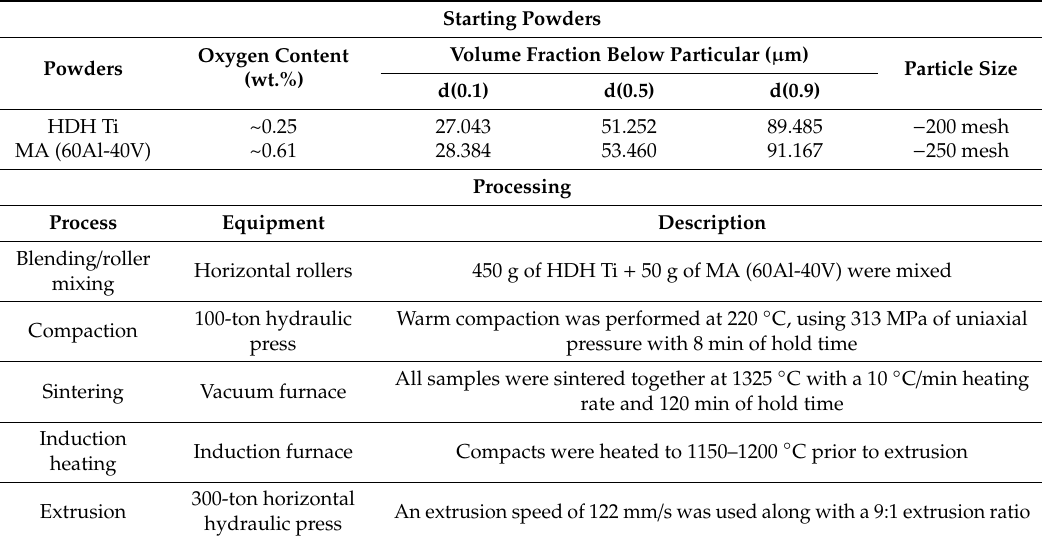
Table 1. Characteristics of the starting powders and processing conditions used to produce